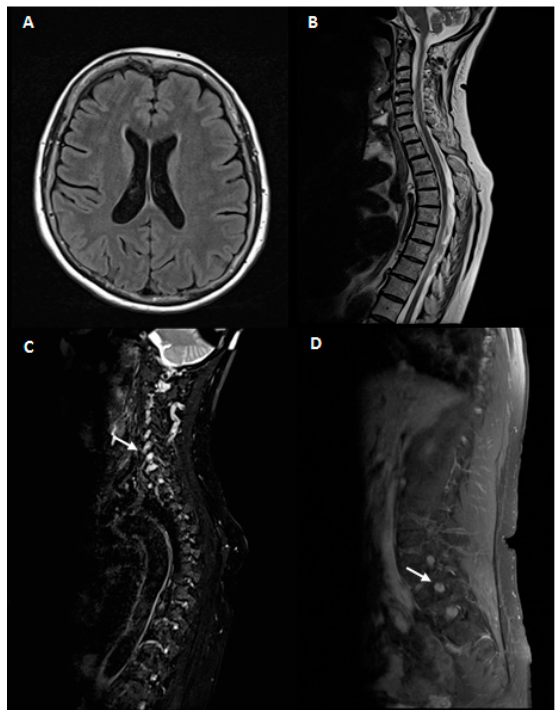
Figure 1. Magnetic resonance imaging(MRI)study. 1.5 Tesla brain and spinal cord MRI. A, B: brain MRI axial T2 fluid-attenuated inversion recovery (FLAIR) ( A ) and spinal cord MRI sagittal T2 fast spin echo (FSE)( B ) of our patient. No abnormalities were noticed. ( C , D ): Fat-suppressed T2 sequences of cervical ( C ) and lumbar ( D ) MRI scans showing hypertrophy of hyperintense nerve roots (white arrows). SSEPs of upper limbs, performed at median nerves, showed normal values Figure 2A; on the contrary, SSEPs of lower limbs evidenced normal latency values of spinal stationary potentials (N22, 21.1 ms right, 20.1 ms left; upper normal limit in our laboratory: 25.8 ms), but a pathological latency of P40 cortical potentials (right 45.2 ms, left 46.5 ms; upper limit in our laboratory: 43.9 ms) with a prolonged central conduction time (CCT, 24.1 ms right, 26.5 ms left; upper normal limit of our laboratory: 21.3 ms), suggesting a dorsal column involvement Figure